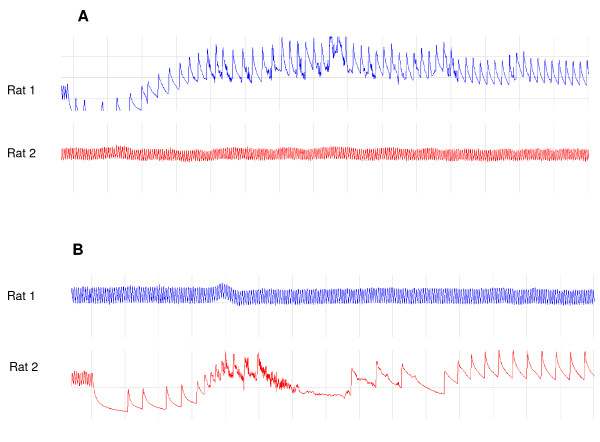
Curves of mean arterial blood pressure illustrating the episodes of hypotension and bradycardia occurring simultaneously with motor events in Rat 1 (blue) and Rat 2 (red) during the infusion of DHC at (A) t = 360 minutes (i.e. following the end of the 3 mg/kg/hr dose) or (B) at t = 170 minutes (i.e. near the end of the 2 mg/kg/hr dose).